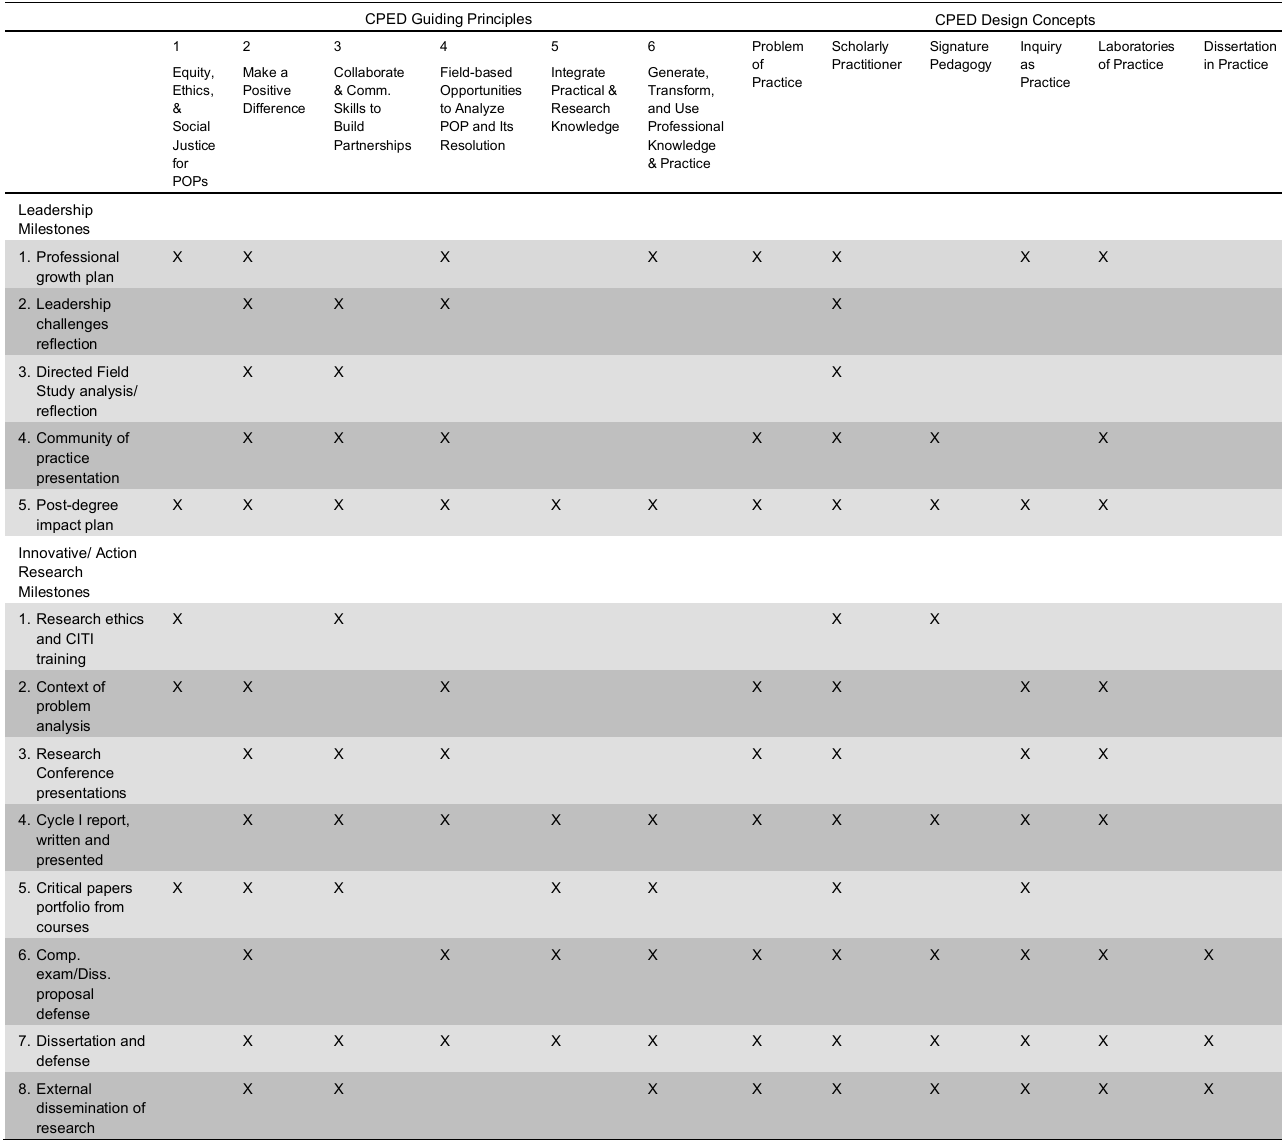
Table 1. Program Milestones by CPED Guiding Principles and Design Concepts CPED Guiding Principles CPED Design